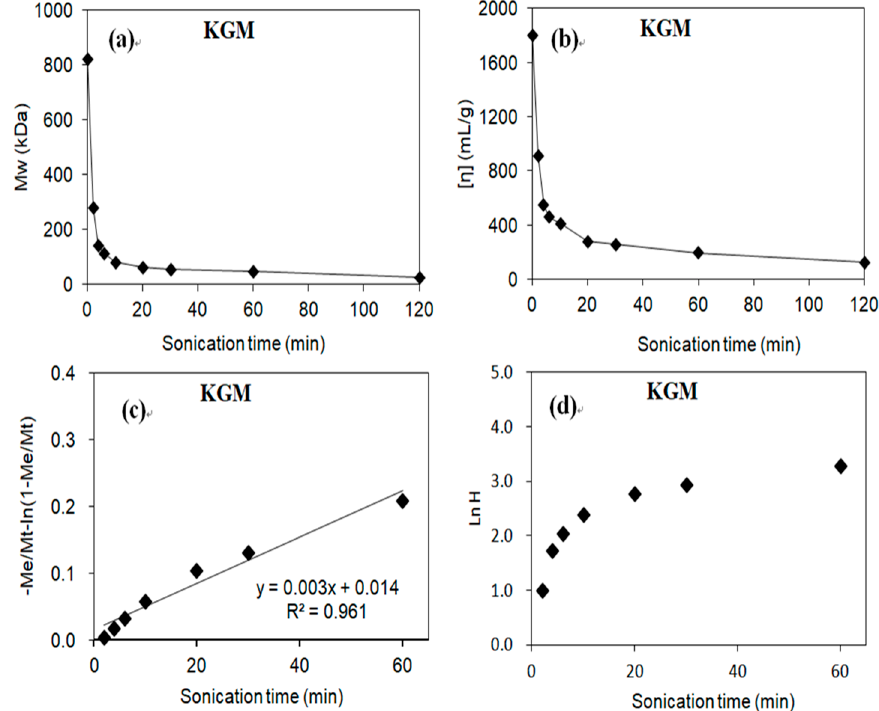
Figure 2. Kinetics of ultrasonic degradation of KGM: ( a ) time courses of molecular weight (MW) change during US treatment; ( b ) time courses of intrinsic viscosity [ η ] change during US treatment; ( c ) MW time courses fitted to the random chain scission model Equation (1); ( d ) MW time courses fitted to the midpoint chain scission model Equation (2); H represents the value of ( M e − M i )/( Mt − M i ).